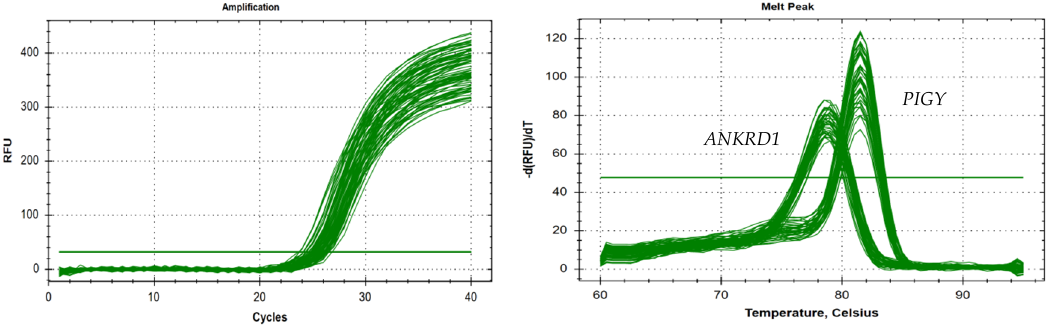
Figure 4. The specificity testing of the PIGY gene and the ANKRD1 gene.